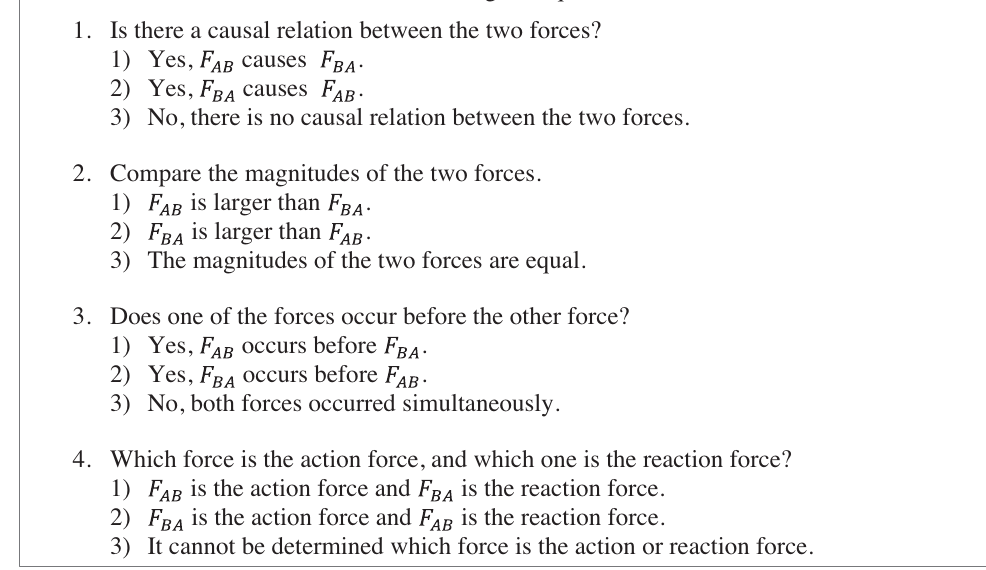
FIG. 1. Design of assessment questions on causal reasoning in Newton ’ s third law. Collision, book, and push are three scenarios of N3L interactions. For each scenario, the same four questions are asked to probe the four attributes of causal reasoning regarding the causality, magnitude, time order, and action-reaction description of the N3L interaction forces. The complete test is shown in the